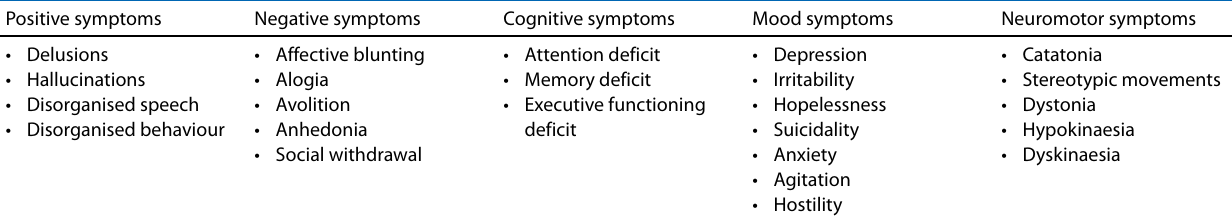
Table 1: The clinical symptom domains of schizophrenia Positive symptoms Negative symptoms Cognitive